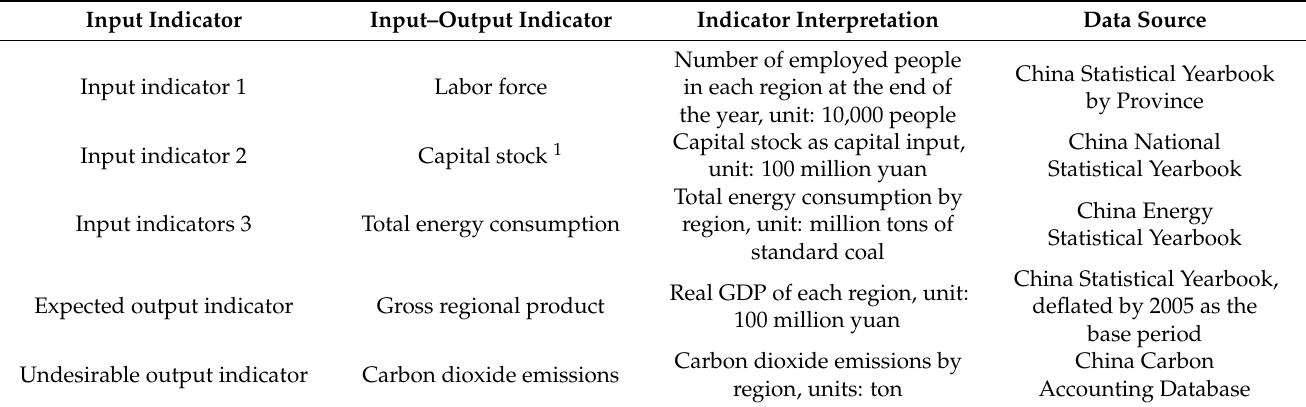
Table 1. Carbon emission efficiency evaluation index